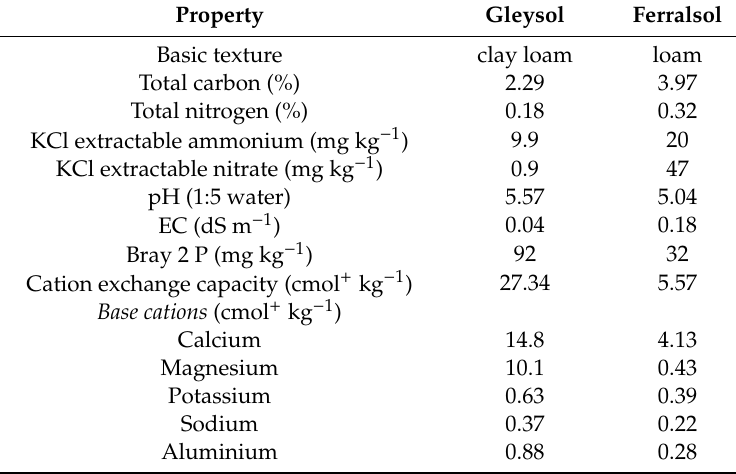
Table 2. Selected physiochemical chemical properties of the 0–100 mm layer of the Gleysol (experiment 1) and Ferralsol (experiments 2 and 3). Property Gleysol Ferralsol Basic texture clay